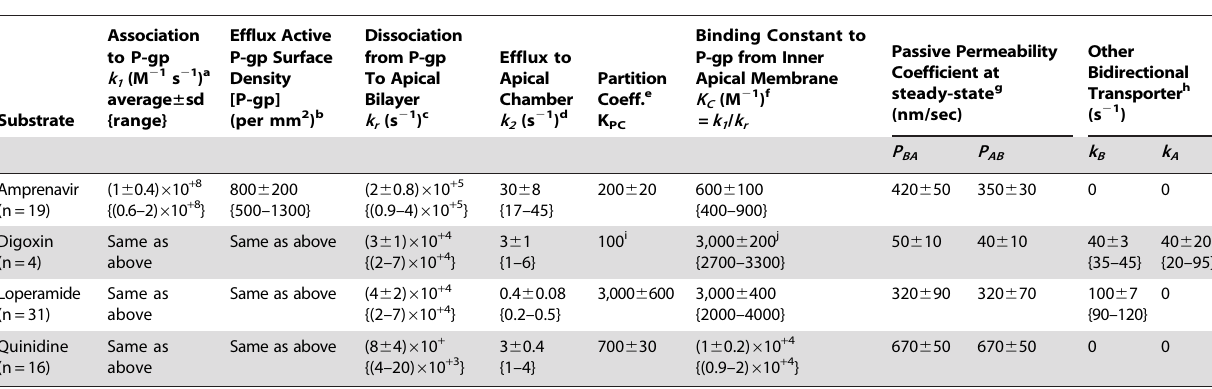
Table 1. Averages and standard deviations of transport parameters for the 24 independent replicate fits.